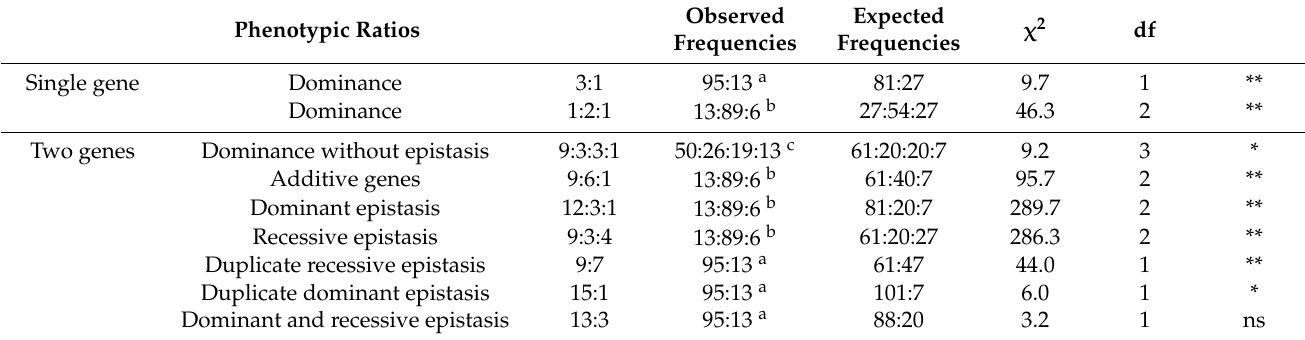
OL antibiosis ratio = (number of oviposition punctures/number of larvae); χ 2 = (observed frequency − expected frequency) 2 /expected frequency; ** = significant at 1% level of probability; * = significant at 5% level of probability; ns = not significant at 1% and 5% level. a number of families with OL antibiosis ratio not significantly different from K07-1544: number of families with antibiosis ratio OL significantly higher than K07-1544. b number of families with OL antibiosis ratio significantly higher than K07-1544: number of families with antibiosis ratio OL not significantly different from K07-1544 and PI165673: number of families with OL antibiosis ratio significantly lower than PI165673. c number of families with OL antibiosis ratio lower than 1.9 = (1.7 + d): number of families with antibiosis ratio OL between 1.9 and 2.0: number of families with OL antibiosis ratio between 2.1 and 2.3: number of families with OL antibiosis ratio